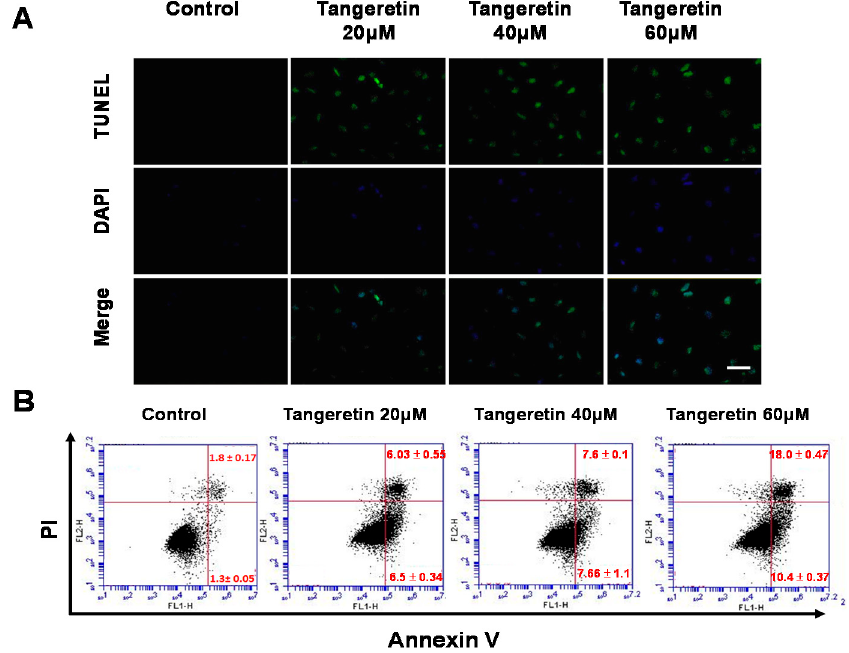
Figure 3. Tangeretin-induced apoptosis in BFTC-905 cells. ( A ) TUNEL/DAPI staining of cells after tangeretin (0, 20, 40, and 60 µ M) treatment. Scale bars = 50 µ m. ( B ) Annexin V/PI labeling with flow cytometry analysis indicated the percentages of cells in early and late apoptosis after tangeretin treatment.